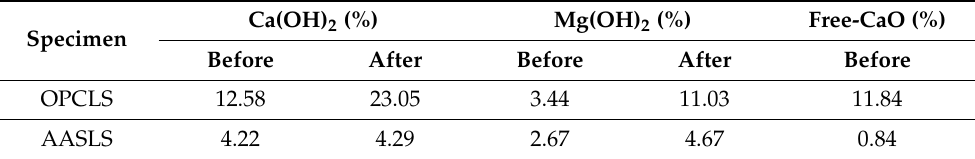
Figure 4. XRD patterns of different hydration processes with EAFLS before and after the autoclave expansion test (left) OPCLS (right) AASLS. Table 4. Effects of different hydration processes on the changes in the amount of Ca(OH) 2 and Mg(OH) 2 before and after the autoclave expansion test and the amount of free-CaO before the autoclave expansion test.